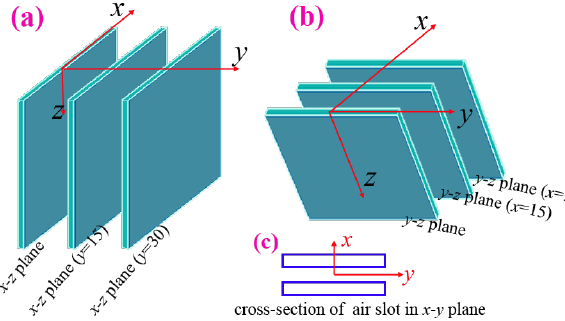
Figure 2. Schematic of the Particle Image Velocimetry (PIV) measurement